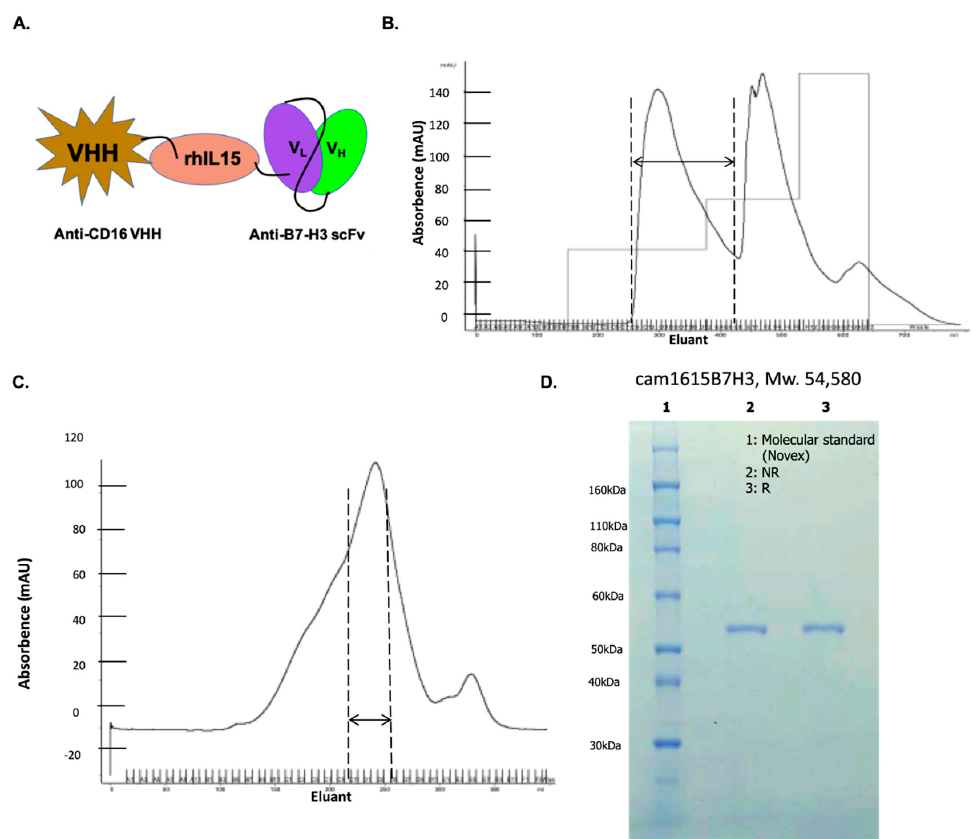
Figure 1. Construction and isolation of cam1615B7H3 tri-specific killer engager (TriKE). ( A ) Schema of the TriKE construct consisting of (left to right) camelid anti-CD16 VHH, Human IL-15, and anti-B7-H3 scFv. ( B ) Chromatography trace from the first-step purification of cam1615B7H3 on an ion exchange (FFQ) column. The collection peak is indicated by the double-sided arrow. ( C ) Chromatography trace from the second-step purification of cam1615B7H3 on a size exclusion chromatography (SEC) column. The collection peak is indicated by the double-sided arrow. ( D ) sodium dodecyl sulfate polyacrylamide gel electrophoresis (SDS-PAGE) gel indicating the purity of the final product after the two orthogonal column steps. The lanes of the gel display molecular marker, non-reduced (NR) product, and reduced (R) product.